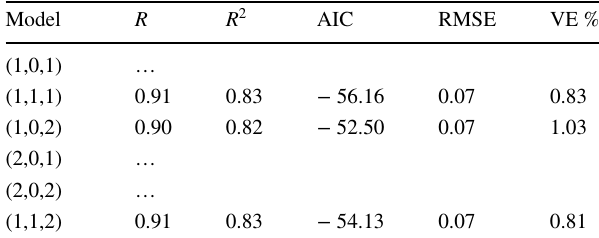
Table 9 The consequences of SAR group, order (1,2) Model